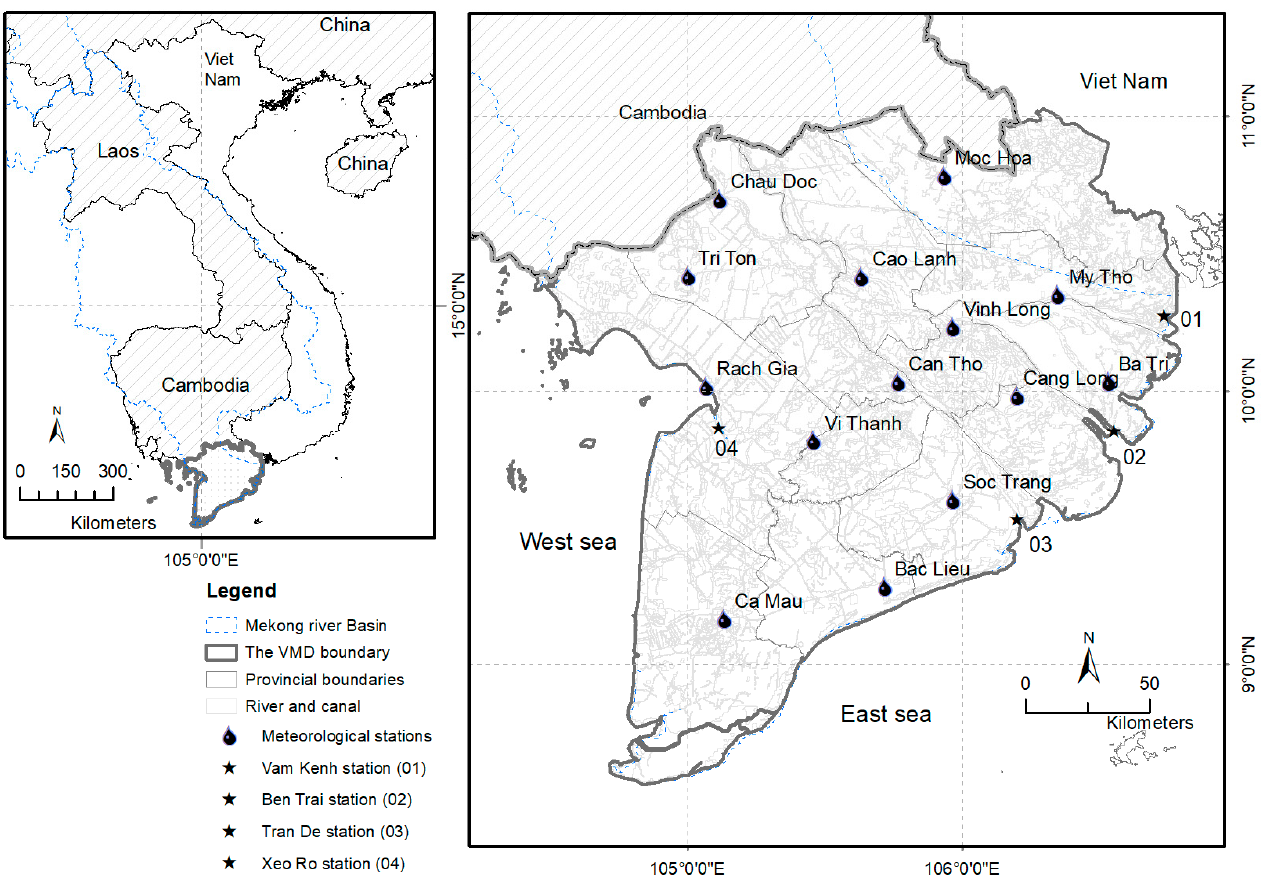
Figure 1. The location of the 14 meteorological stations and salinity stations (Vam Kenh, Ben Trai, Tran De, and Xeo Ro) utilized in the Vietnamese Mekong Delta.